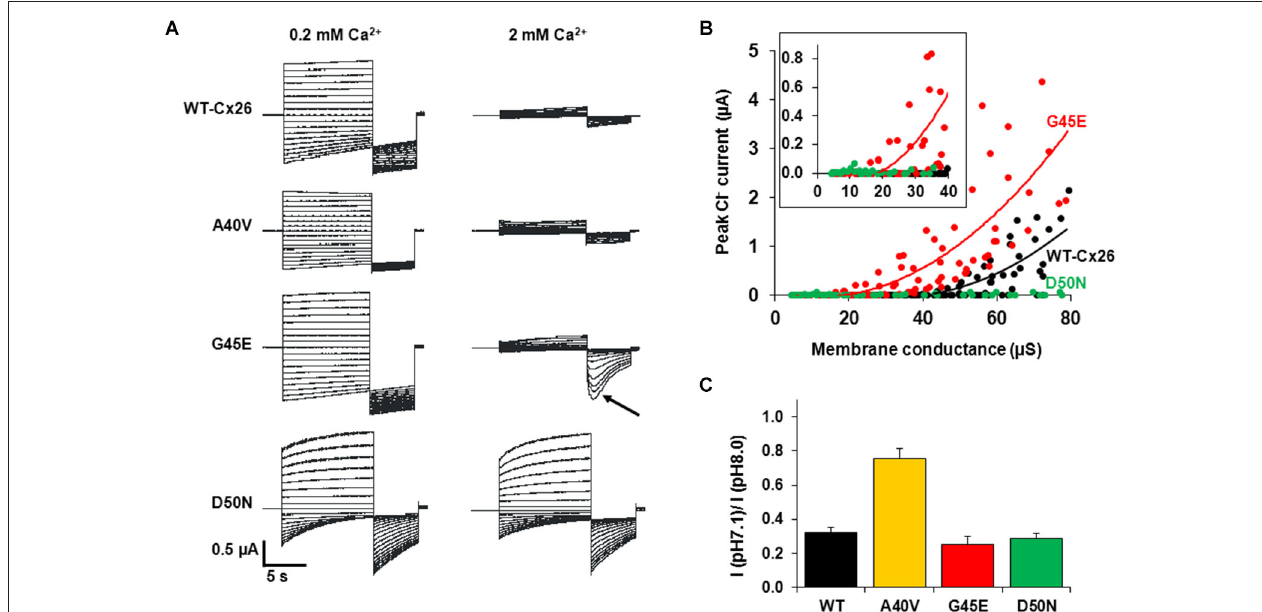
FIGURE 5 | KID syndrome mutations produce functional HCs, but with differential effects on regulation by Ca 2 + and pH and permeability to Ca 2 + . (A) Representative currents elicited by a series of voltage steps (10-s steps from +60 to − 100 mV in intervals of 10 mV followed by a 5-s step to − 110 mV) applied to oocytes expressing WT Cx26, A40V, G45E and D50N. Oocytes were voltage clamped